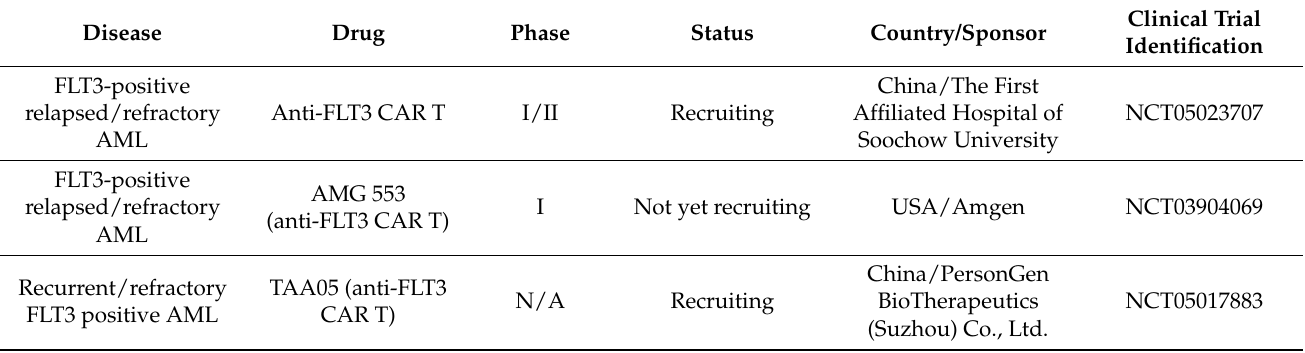
Table 2. Anti-FLT3 CAR T-cell trials